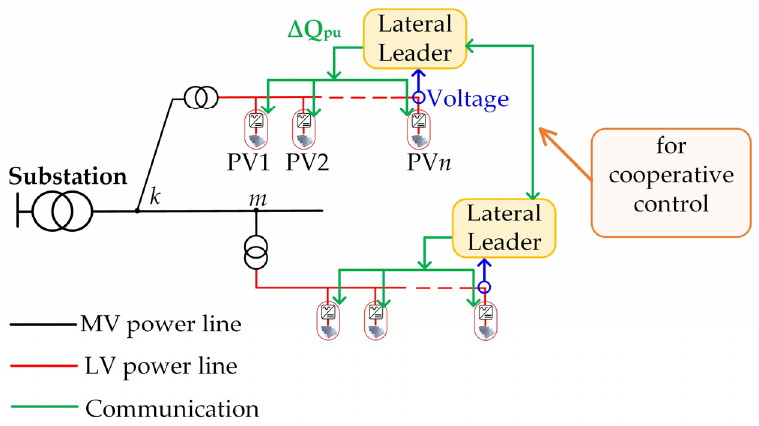
Figure 3. Proposed lateral based controller.